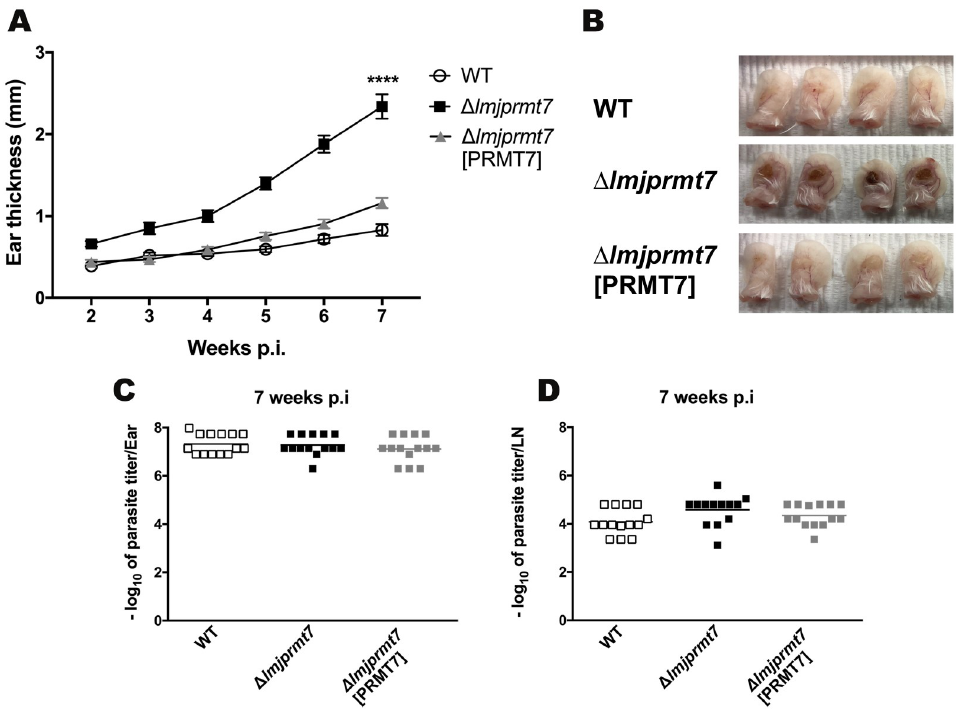
Fig 3. Deletion of Lmj PRMT7 in a nonpathogenic strain leads to lesion formation not affecting parasite load. (A) BALB/c female mice (n = 5 per group) were injected intradermally in both ears with 100,000 metacyclic promastigotes and ear thicknesses was followed for 7 weeks. (B) Photographs of infected ears on the 7th week post infection, taken by the author. Results shown are the mean ± SEM of twenty ears, five mice/group, from two independent experiments, �� p < 0.01, ���� p < 0.0001, comparing infection with wild type and Δ lmjprmt7 , using 2way ANOVA, with Tukey’s multiple comparison test. (C-D) Parasite burden determined by limiting dilution analysis (LDA) in the site of infection (ear, left) and draining lymph node (LN, right) after 7 weeks post-infection. Results shown are the mean ± SEM of fourteen ears from two independent experiments. Unpaired, two-tailed student’s t-test.